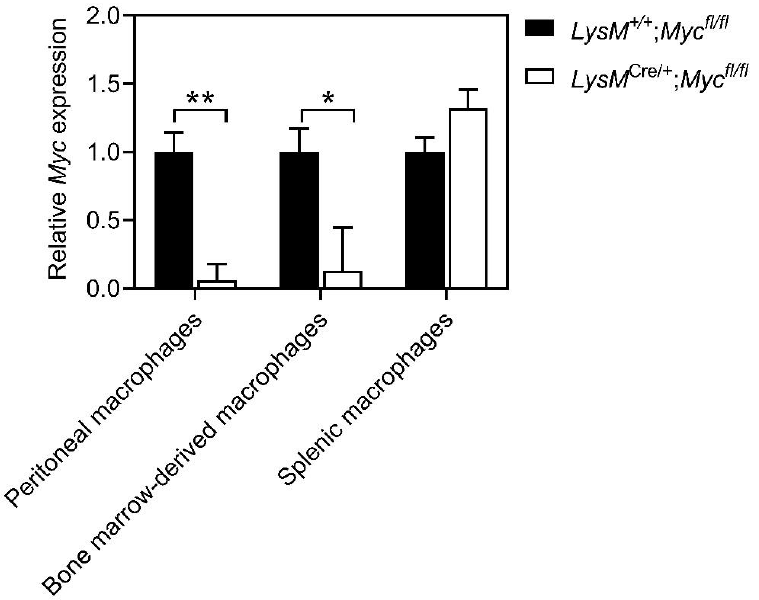
Figure 1. LysM Cre -mediated reduction in Myc expression in mature macrophages. Expression of Myc in peritoneal, bone-marrow-derived, and splenic macrophages isolated from LysM +/+ ; Myc fl/fl and LysM Cre/+ ; Myc fl/fl mice. n ≥ 3 mice per group. Data represent mean ± SEM; * p < 0.05, ** p < 0.01, with statistical significance determined by an unpaired Student’s t -test.